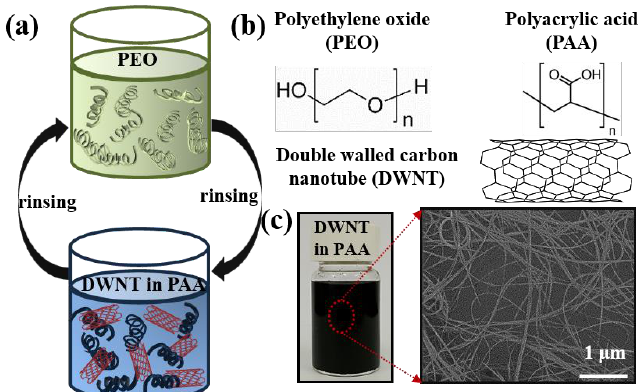
Figure 1. ( a ) Schematic of the layer-by-layer process for PEO/DWNT-PAA thin films. ( b ) Molecular structures of PEO, PAA, and DWNT. ( c ) Optical image of aqueous of DWNT stabilized by PAA in